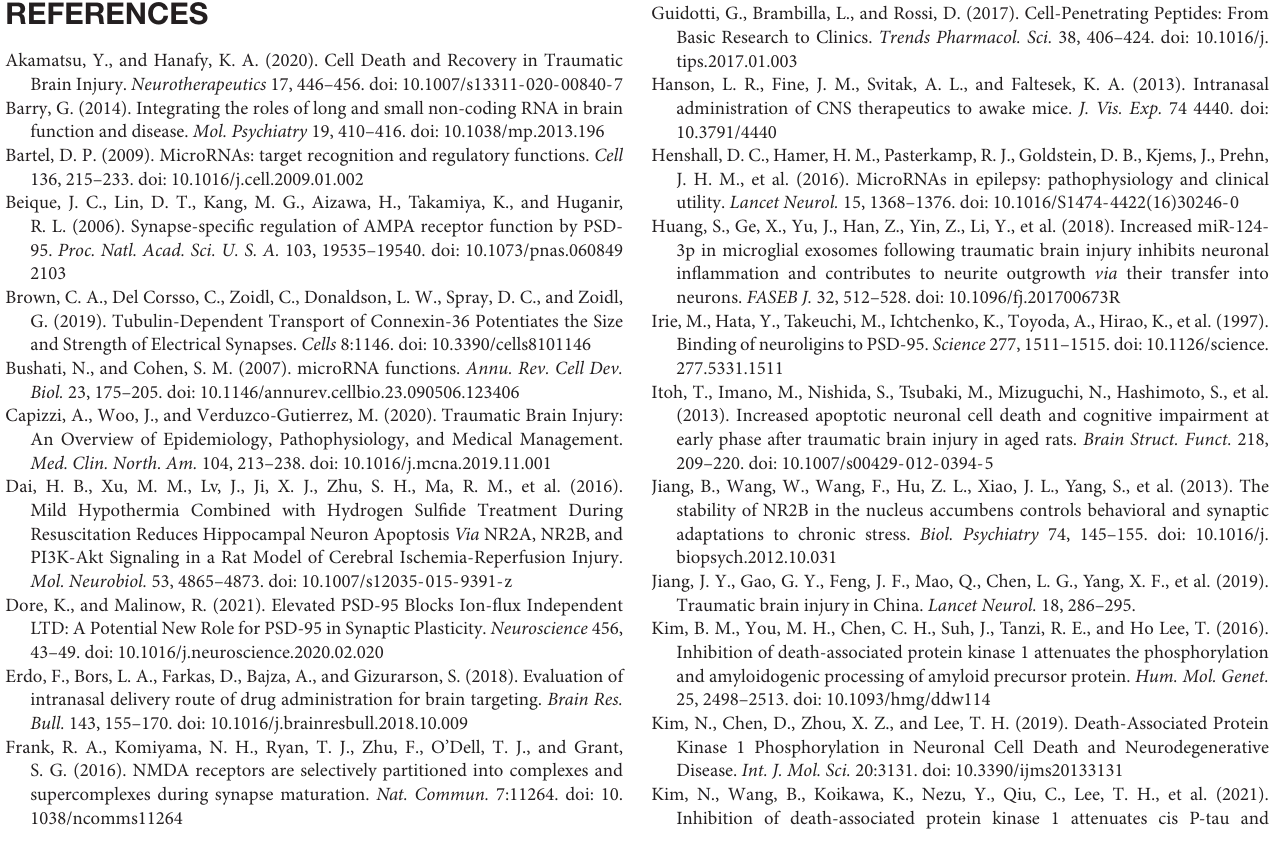
Supplementary Figure 1 | Expression pattern of DAPK1 in the cortex; Scale bar, 100 µ m. Supplementary Figure 2 | Alterations of miR-98, miR-124, and miR-141 in the blood plasma of TBI patients. Supplementary Figure 3 | Expression level of p-ERK/ERK in different